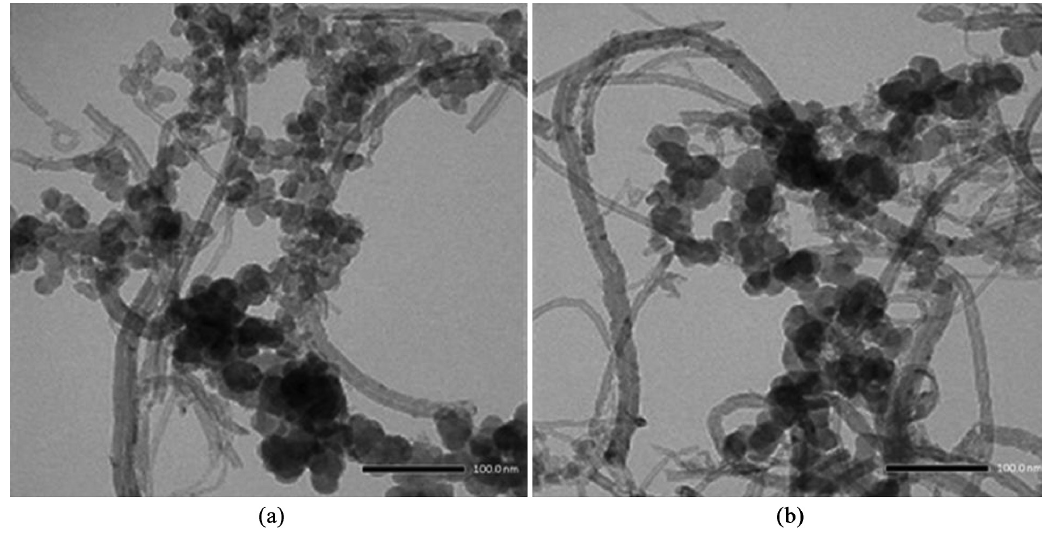
Figure 8. TEM images of LMO/CNTs (2 wt%) and LNMO/CNTs (2 wt%) nanocomposites.